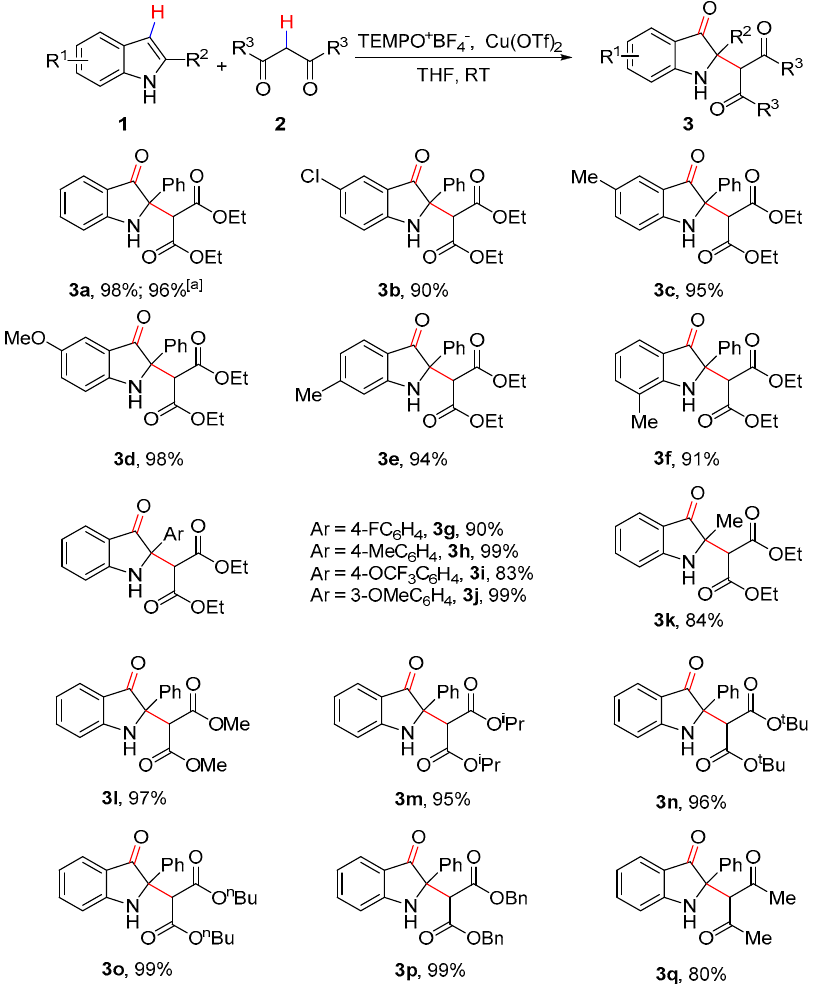
Figure 3. Cross-dehydrogenative coupling of indoles with 1,3-dicarbonyl compounds.